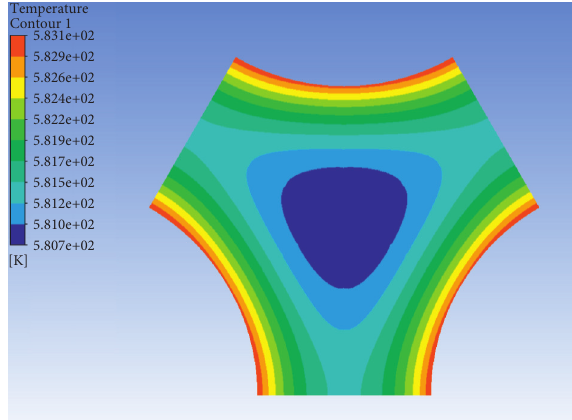
Figure 10: Temperature